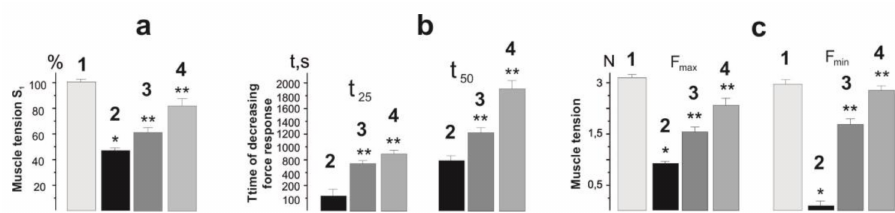
Figure 3. Parameters of contractile activity of muscle soleus rat after chronic intoxication with glyphosate for 30 days: ( a ) integrated power of muscle contraction throughout the entire period of stimulation (S 1 ), presented as a percentage of control values; ( b ) time of decreasing the force response by 50% (t 50 ) and 25% (t 25 ) from the initial values; ( c ) maximum (F max ) and minimum (F min ) fixed forces of muscle contraction throughout the entire duration of stimulation. 1—control group (native muscle); 2—the glyphosate group; 3—the glyphosate+C 60 fullerene (0.5 mg/kg) group; 4—the glyphosate + C 60 fullerene (1 mg/kg) group; * p < 0.05 relative to the control group; ** p < 0.05 relative to the glyphosate